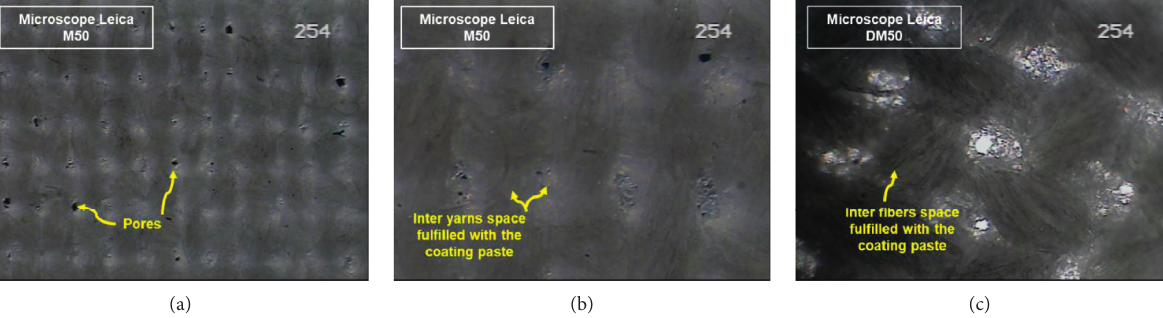
Figure 7: Surface morphology of the coated cotton-PES woven fabric (fluorocarbon resin: 15%, acrylic paste: 20g m − 2 , and crosslinking